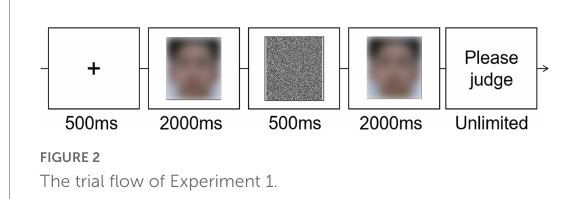
FIGURE2 The trial flow of Experiment 1.